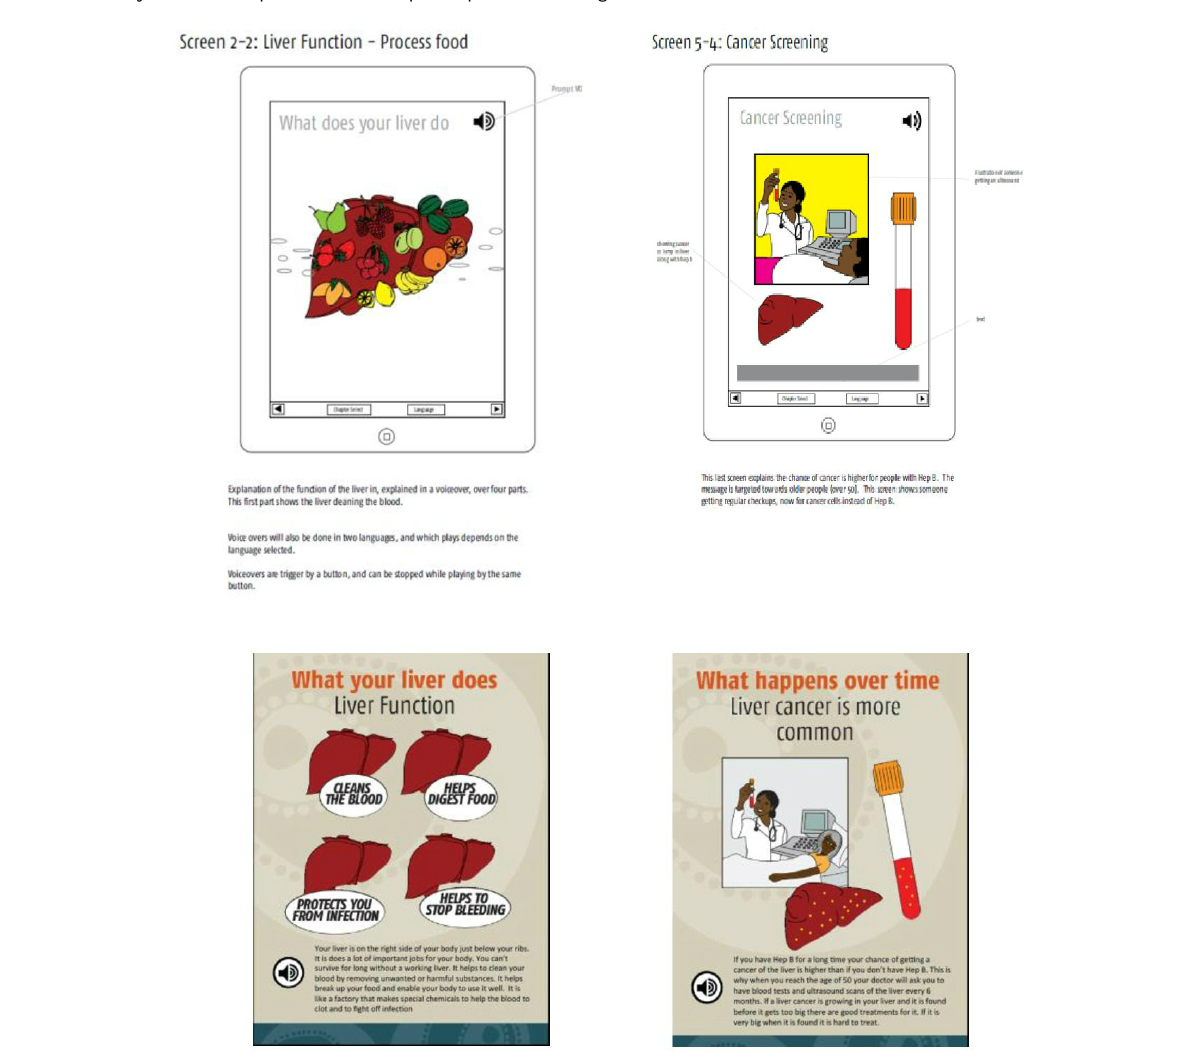
Figure 3. Screen-by-screen examples of the development process showing first and last